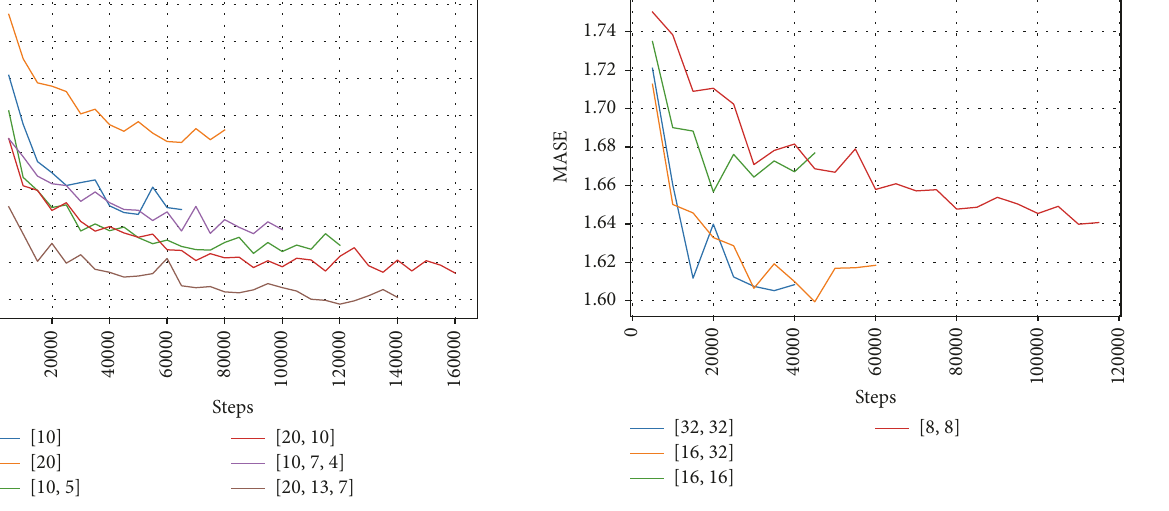
Figure 9: Trend in MASE for different FNNs with SELU activation function and 6h historical input data.